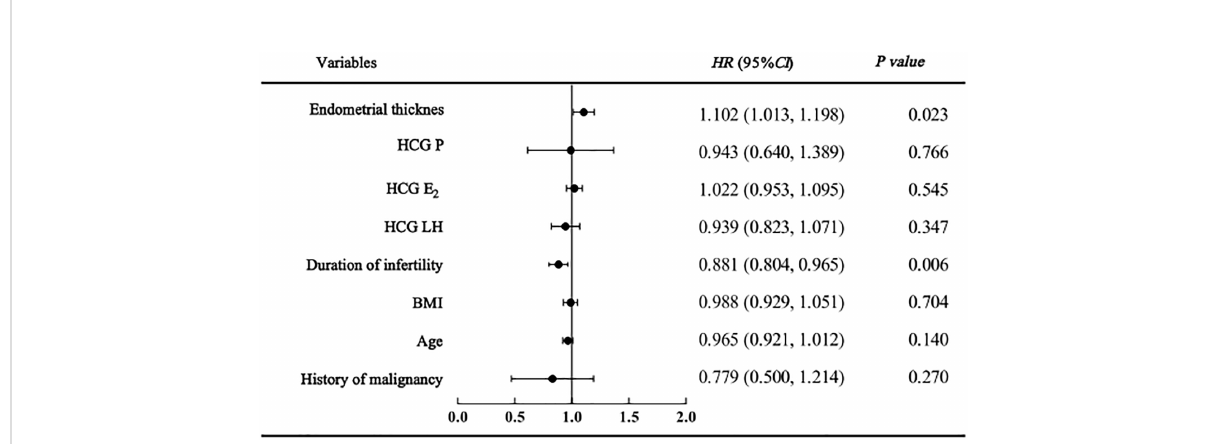
FIGURE 3 Cox regression analysis forest plot of live birth affecting